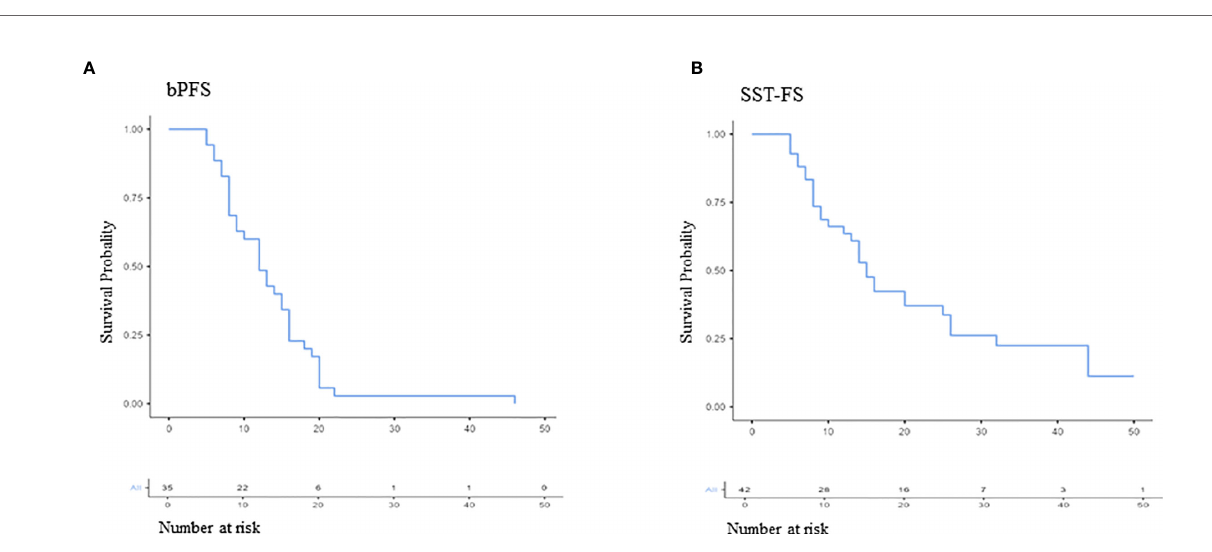
FIGURE 3 | Kaplan – Meier curves of biochemical progression-free survival (bPFS; A ) and second-line systemic treatment free survival (SST-FS; B